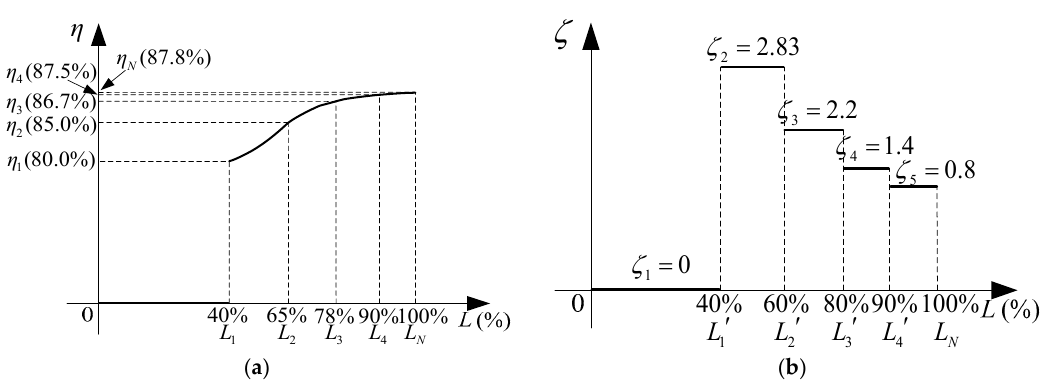
Figure 2. Key parameters of CHP: ( a ) overall efficiency of CHP; and ( b ) heat to electricity ratio (HTER) of CHP.